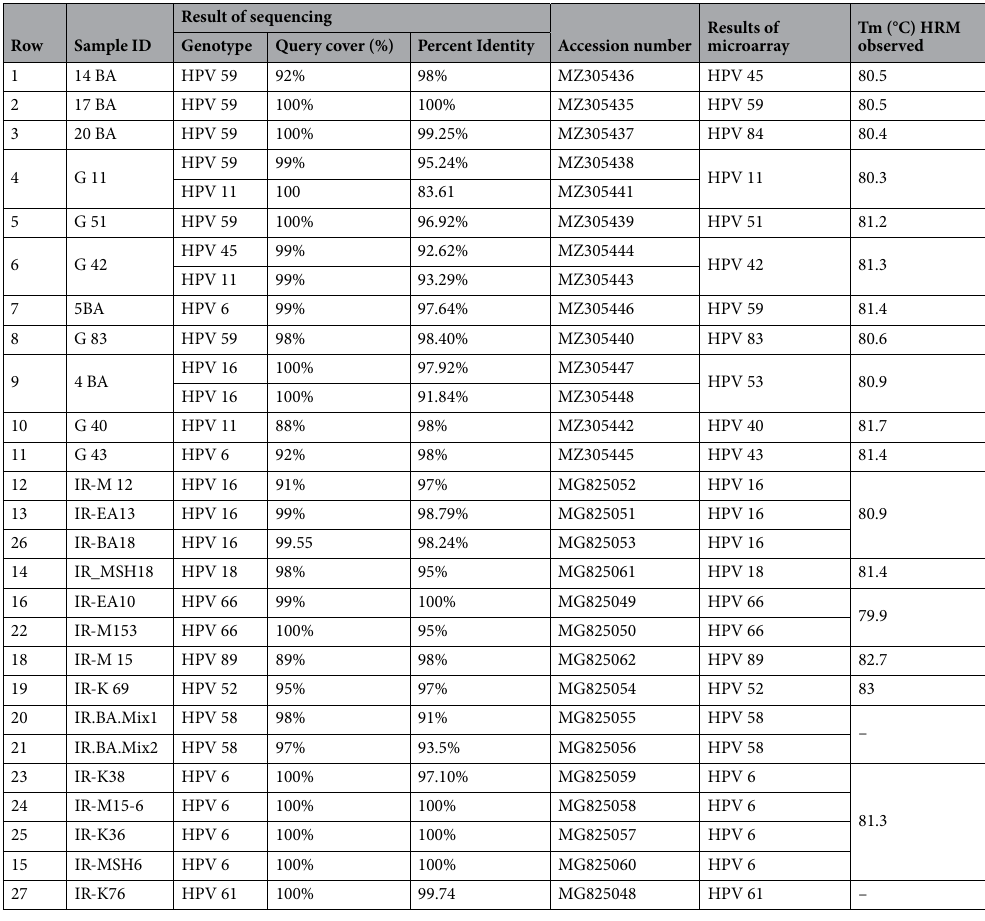
Table 3. Comparison of three methods (microarray, sequencing (FRG2/5 primer), and HRM) for genotyping HPV among positive